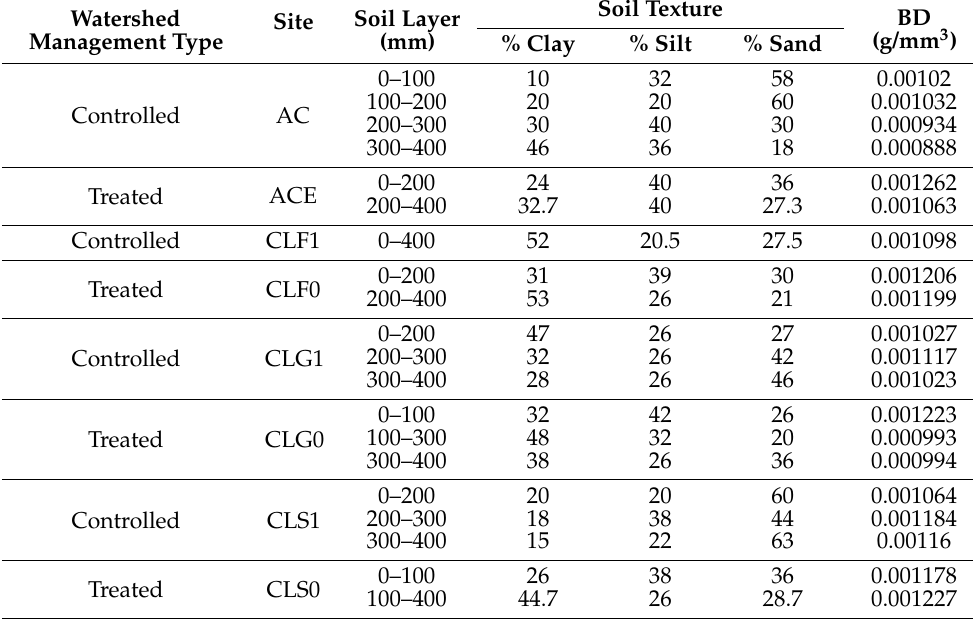
Table 4. soil hydraulic parameters estimation from measured soil texture & bulk density